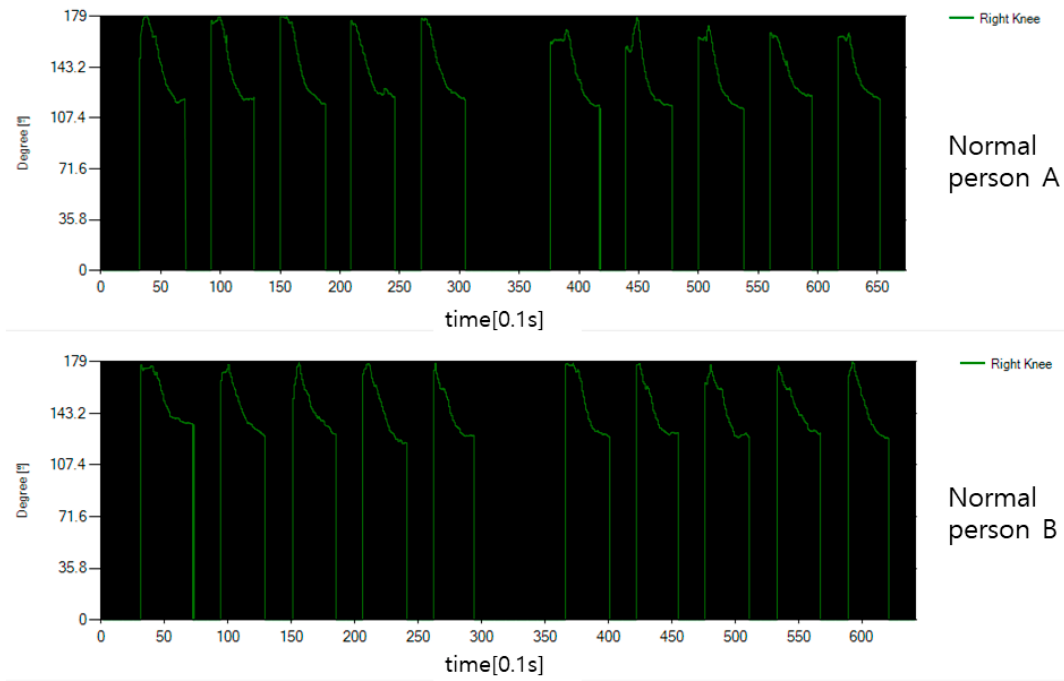
Figure 11. The knee angle data of a normal person’s sitting motion.